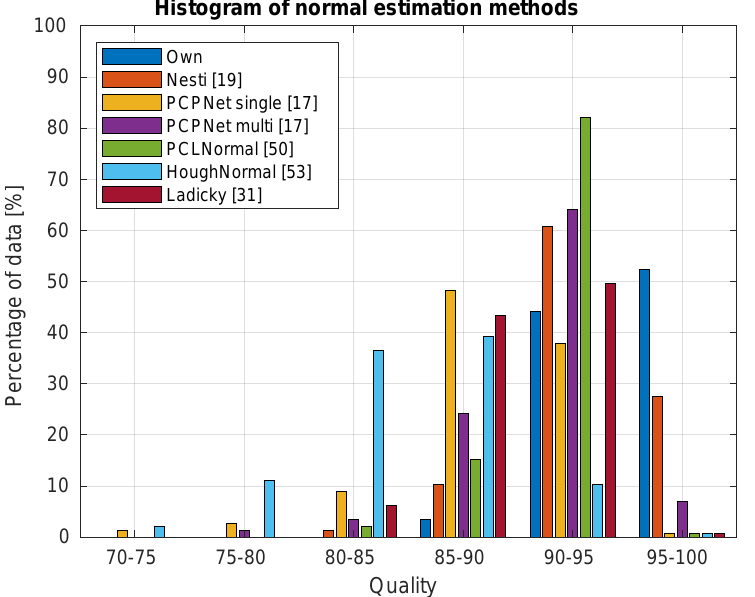
Figure 5. The histogram of the normal estimation for different methods. It can be see the distribution of quality across the data. (For example, for our method, from the analyzed dataset, approximately 52% of the data returned a quality value between 95 and